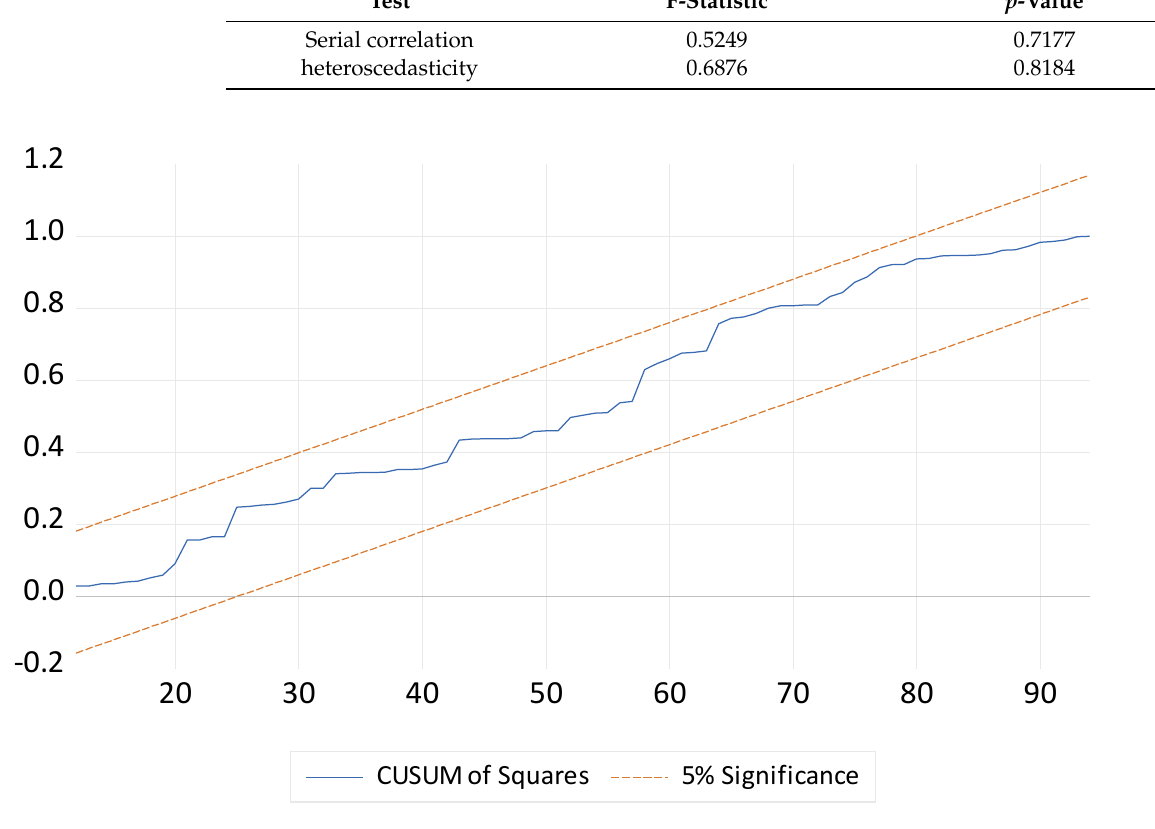
Figure 3. Model stability.